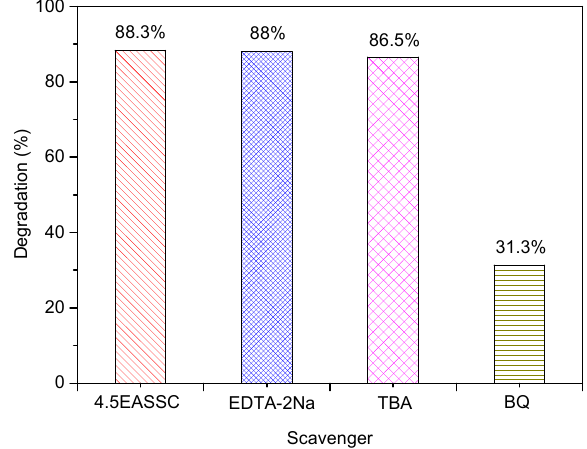
Figure 7. The trapping experiments of hydroxyl radical (•OH), superoxide radical (•O 2 − ) and photogenerated hole (h + ).